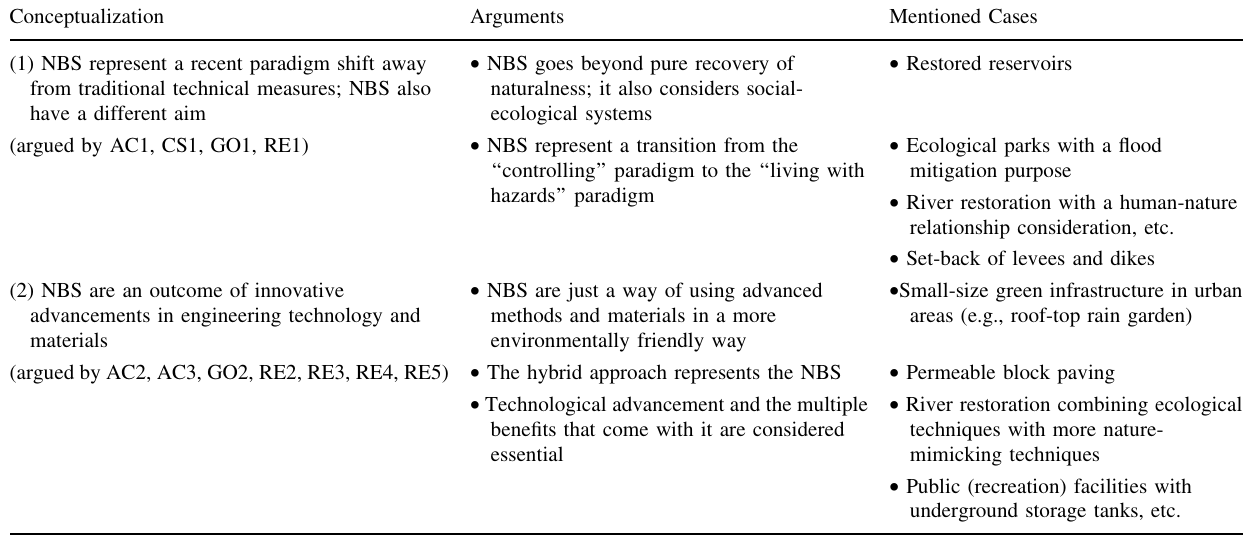
Table 2 Typology of the experts’ conceptualization of nature-based solutions (NBS) for flood risks Conceptualization